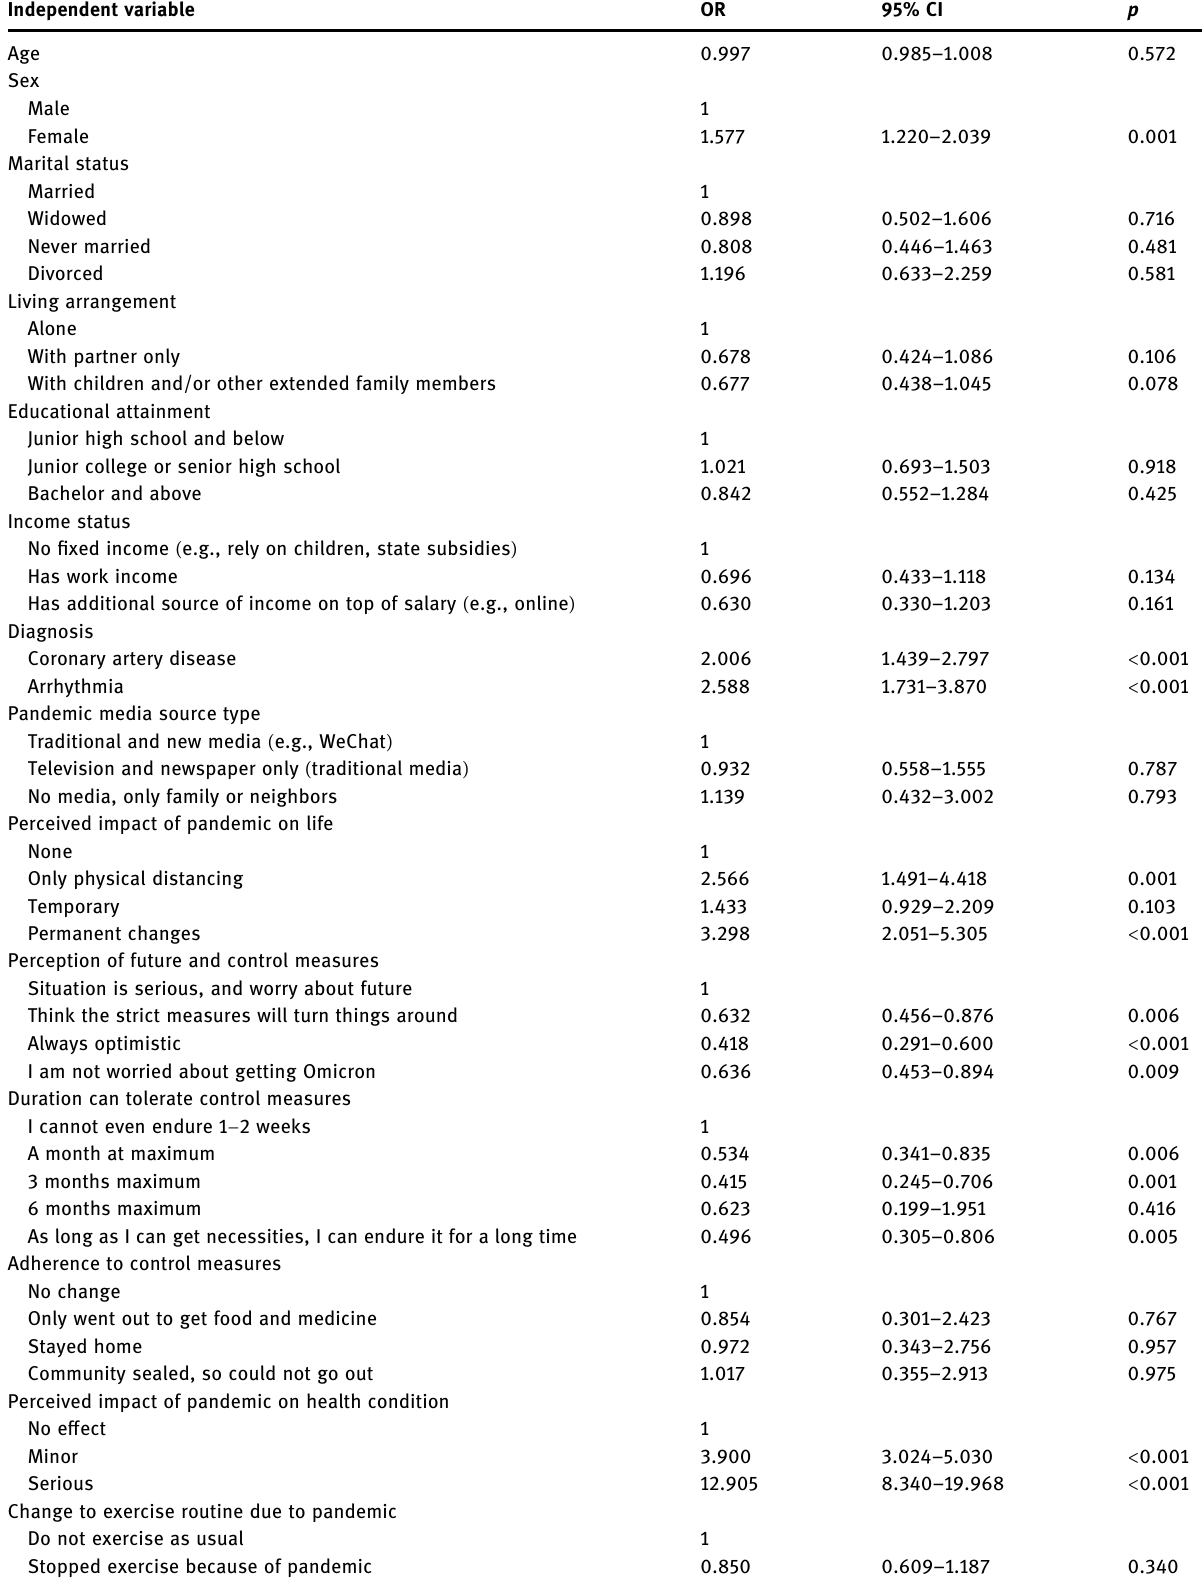
Table 4: Model assessing correlates of